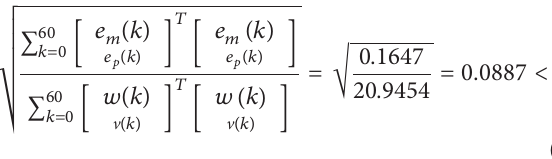
0.1647 , and hence the maximum disturbance attenuation level is